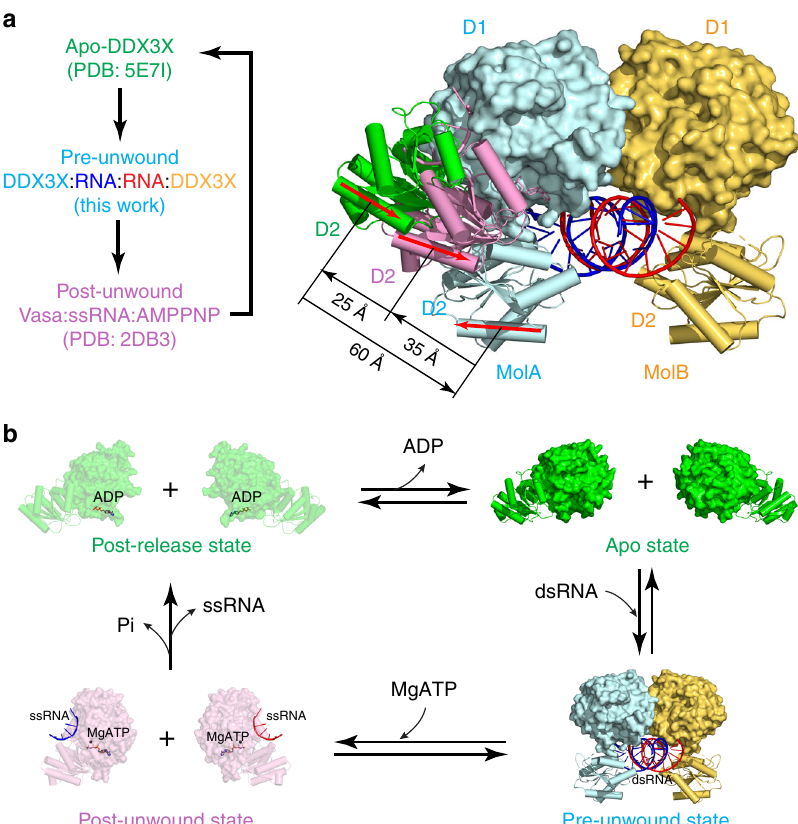
Fig. 5 Unwinding of double-stranded RNA (dsRNA) by DEAD-box helicases. a Conformational difference between the apo-DDX3X (in green, PDB: 5E7I), DDX3X:dsRNA:DDX3X (in cyan and orange, this work), and Vasa:MgAMPPNP:ssRNA (in pink, PDB: 2DB3) structures. The structures are aligned based on C α positions in D1. The D1 of the DDX3X:dsRNA:DDX3X structure is illustrated as a molecular surface, and those of other structures are not shown for clarity. The D2 of all three structures are shown as cartoon models (helices as cylinders, strands as arrows, and loops as tubes). The orientation of D2 relative to the fi xed D1 at each state are indicated with a red arrow on the same α -helix in D2. b Represented by the apo (PDB: 5E7I), pre-unwound (this work), post-unwound (PDB: 2DB3), and post-release (PDB: 4PXA) states, the functional cycle explains a four-step mechanism of RNA duplex unwinding by DEAD-box